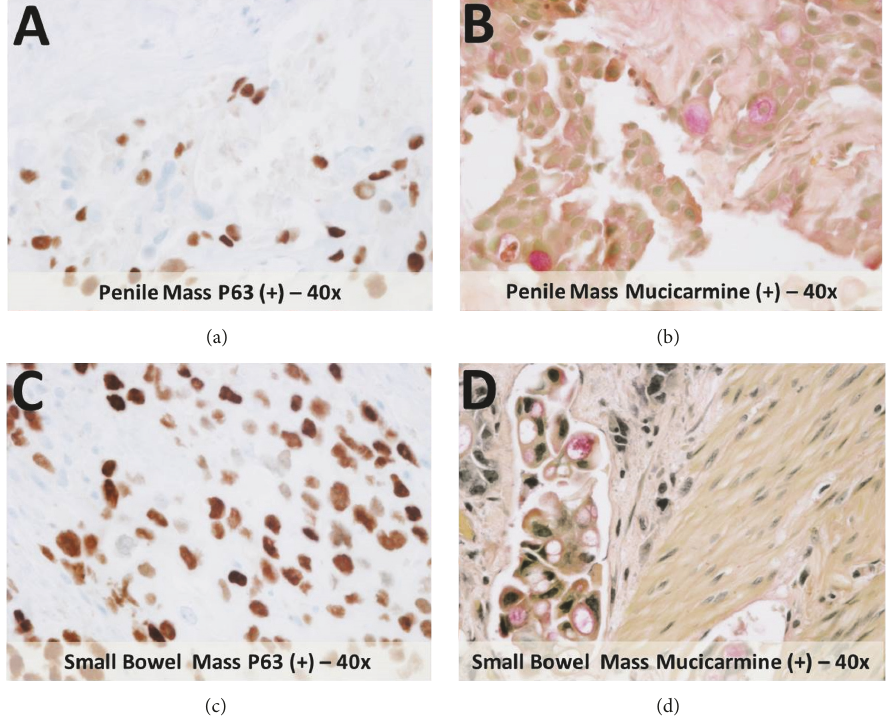
Figure 2: Immunohistochemical analysis of the penile mass demonstrates positive staining with an indicator for squamous cell carcinoma, p63 (a), and positive staining with an indicator for adenocarcinoma, mucicarmine (b). The small bowel mass demonstrates a similar immuno- staining profile and is positive with both p63 (c) and mucicarmine (d) immunostains.